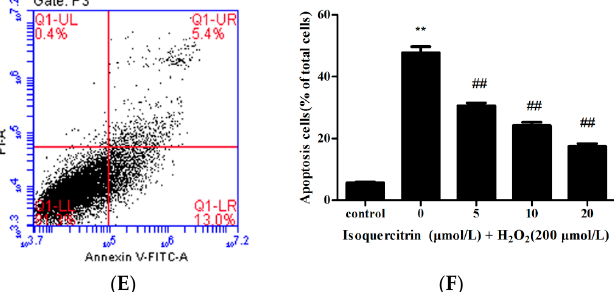
Figure 3. Effects of isoquercitrin on H 2 O 2 -induced apoptosis in EA.hy926 cells measured by flow